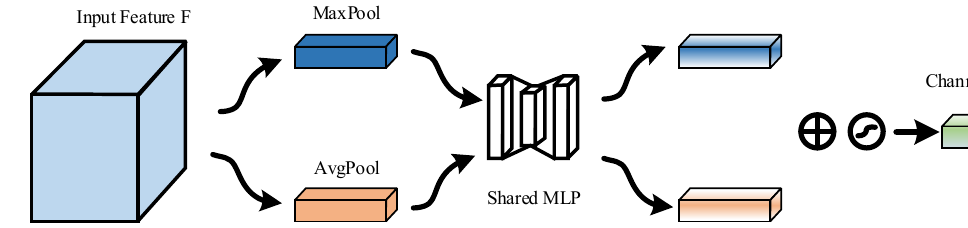
Figure 5. The network structure of CAM.